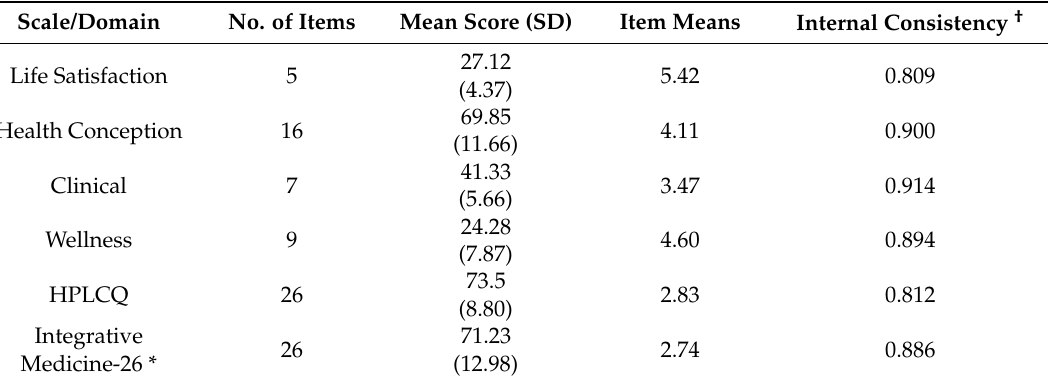
Table 3. Descriptive statistics and internal consistency of Satisfaction with Life (SWL), Health Conception (HC), Healthy Lifestyle and Personal Control Questionnaire (HPLCQ) and Integrative Practice (IM)-26 scales and